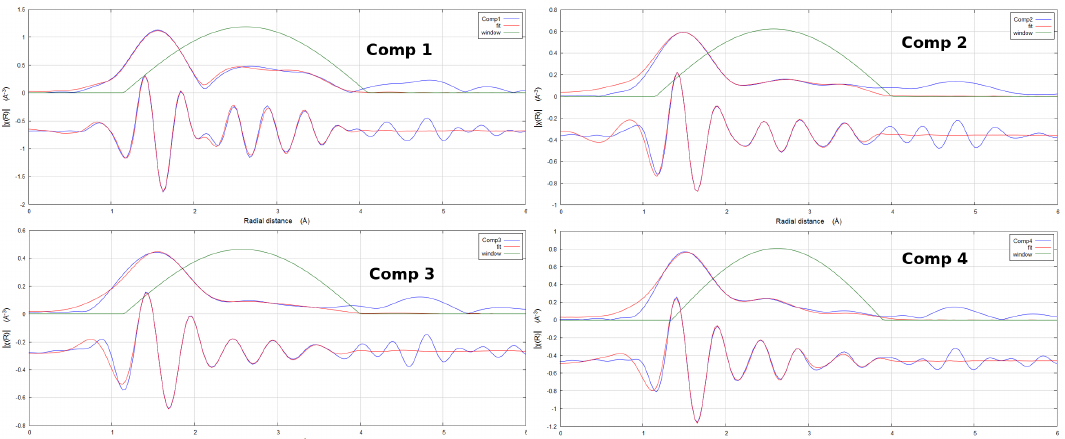
Figure 3. Fourier transform of EXAFS signal in R-space of the four MCR-ALS pure components (blue). Top curve in each plot corresponds to magnitude and bottom curve to real-part contribution. Fit of the real-space EXAFS signal (red) and the range in which the fit was carried out